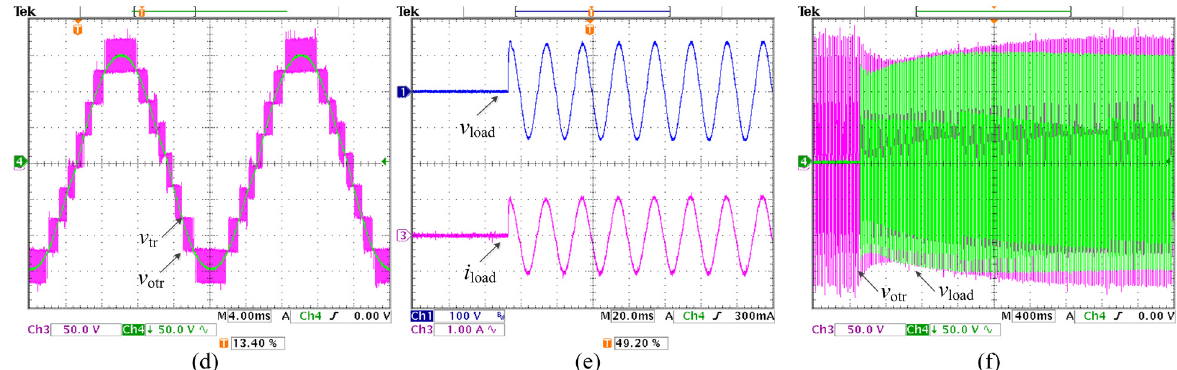
Figure 14. Experiment results: ( a ) The currents of transformer, CH1: the voltage of phase A in the primary side v sa , CH3: the current of phase A on the primary side i sa , CH2: the current of phase A on secondary side i a1 , CH4: the current of phase A on secondary side i a2 ; ( b ) The DC voltage without LC filter circuit and voltage and current of load, CH1: DC voltage V dc1 , CH2: DC voltage V dc2 , CH3: output voltage v o , CH4: the current of load i load ; ( c ) The DC voltage with LC filter circuit and voltage and current of load, CH1: DC voltage V dc1 , CH2: DC voltage V dc2 , CH3: output voltage v o , CH4: the current of load i load ; ( d ) The output voltage and load voltage, CH3: output voltage v otr , CH4: load voltage v tr ; ( e ) The voltage and current of load when the load step change, CH1: load voltage v load , CH3: load current i load ; ( f ) Dynamic waveforms of voltage when the load step changes, CH3: output voltage v otr , CH4: load voltage v tr